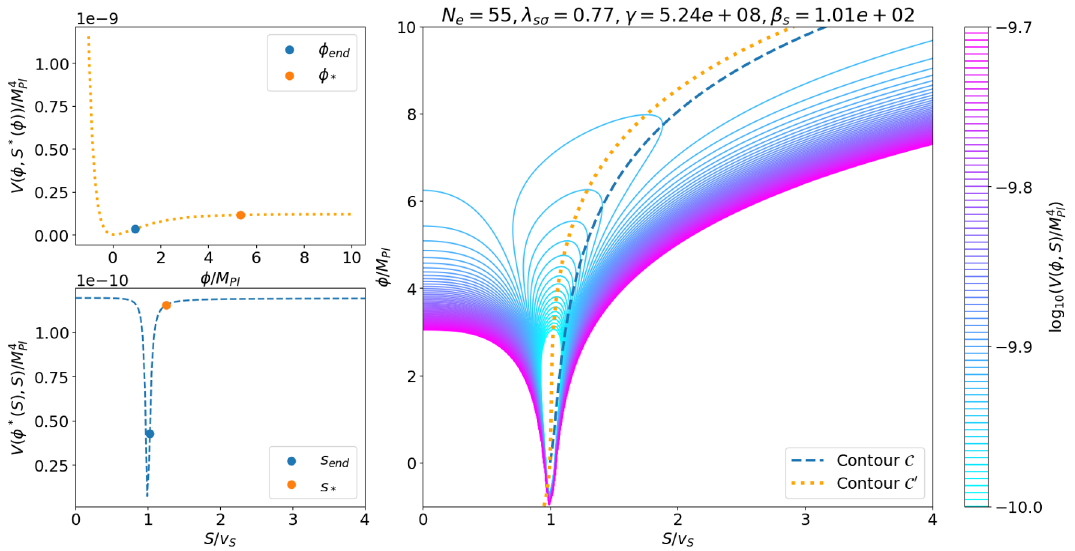
Figure 7 . Scalar potential for benchmark point 1 defined in table 1. The two contours defined in eqs. (4.11) and (4.18) are shown on top of the contour plot of V ( S, φ ) (4.9) (right) and the corresponding 1d inflaton potentials